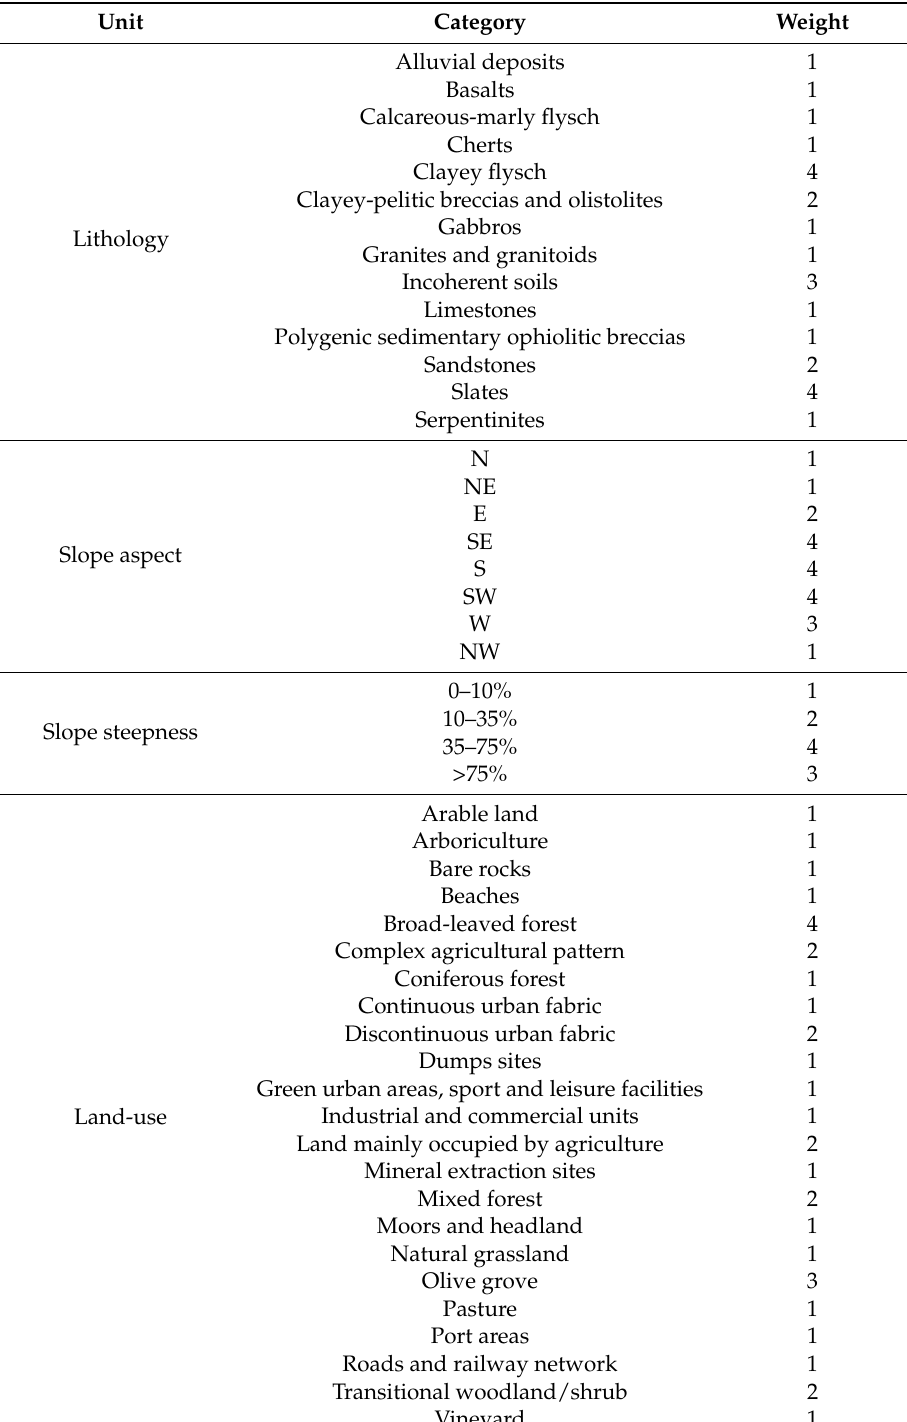
Table 7. Weights associated with each unit in the thematic maps, based on the incidence of landslides in the different categories. For the lithology, slope aspect, steepness and land-use classes, scores ranged from 1 (“low” category in Tables 4–6) to 4 (“very high” category in Tables